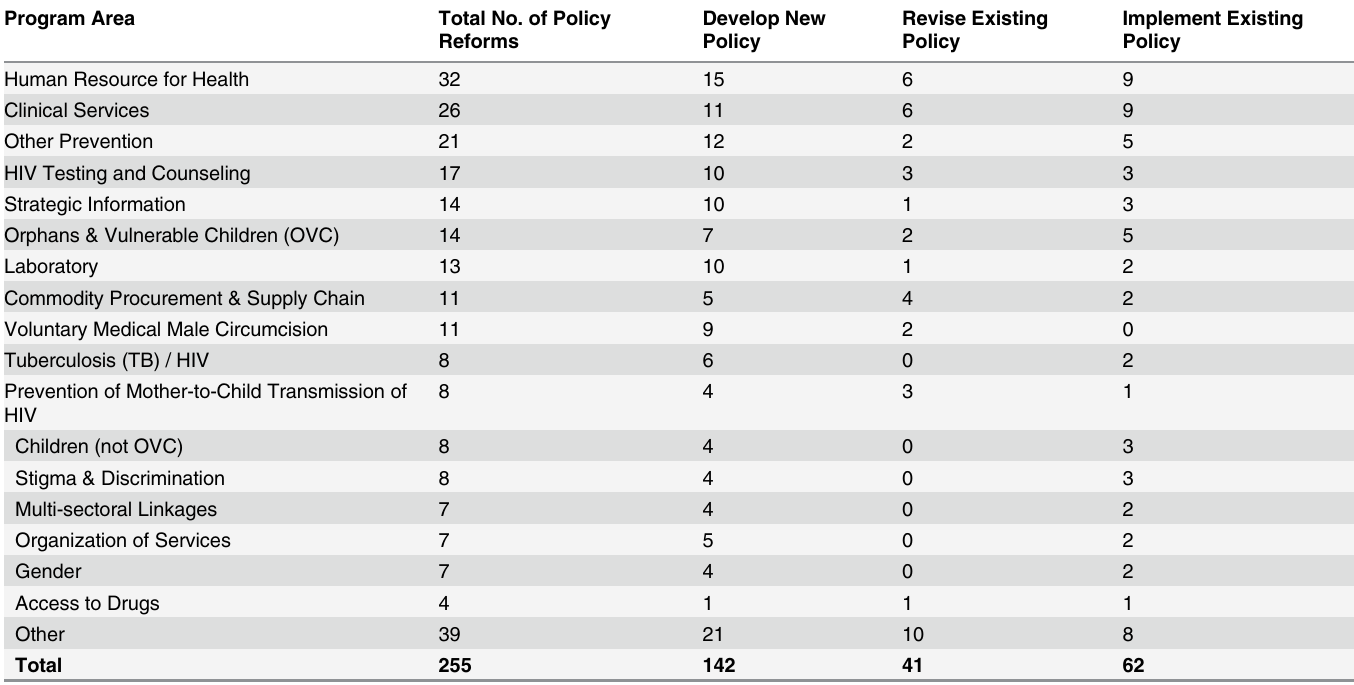
Table 1. Policy Reforms planned in 22 PEPFAR Partnership Frameworks.